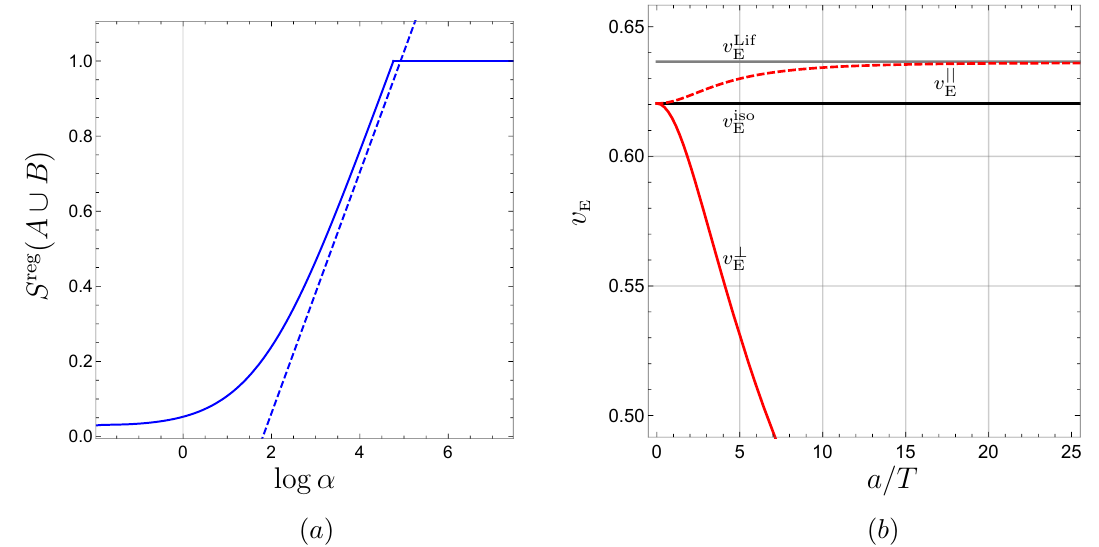
Figure 8 . (a) S reg ( A [ B ) as a function of log (cid:11) . Here we consider a strip oriented orthogonally to the anisotropic direction, a=T = 8 : 56 and u = 1 : 097. The dashed line shows the linear behaviour H of S reg ( A [ B ) as a function of log( (cid:11) ). The angular coe(cid:14)cient of this straight line is given by eq. (3.33). (b) Entanglement velocity as a function of the anisotropy parameter. The continuous red curve represent the result for v ? , while the dashed red curve represents the result for v jj p E black horizontal line is the isotropic result v iso = 2 = 3 3 = 4 , whereas the gray horizontal line is E